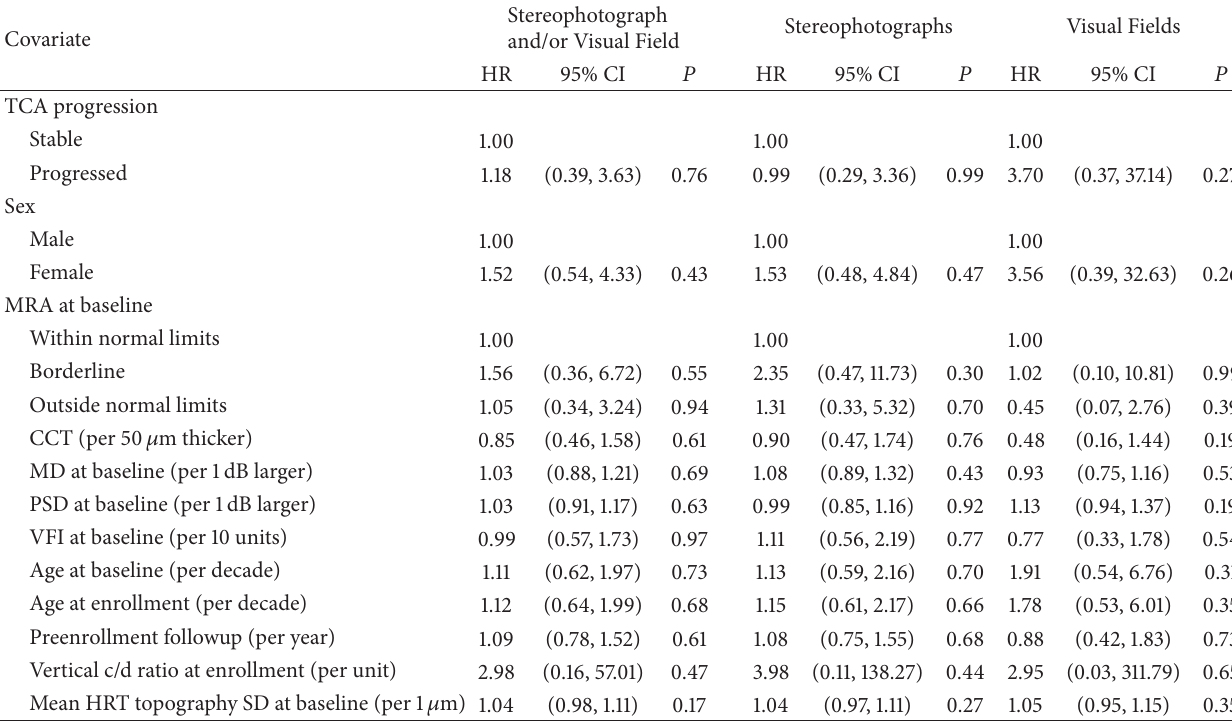
Table 3: Univariable Cox models for the hazard of glaucoma progression by TCA status and other potential prognostic factors. Stereophotograph Covariate